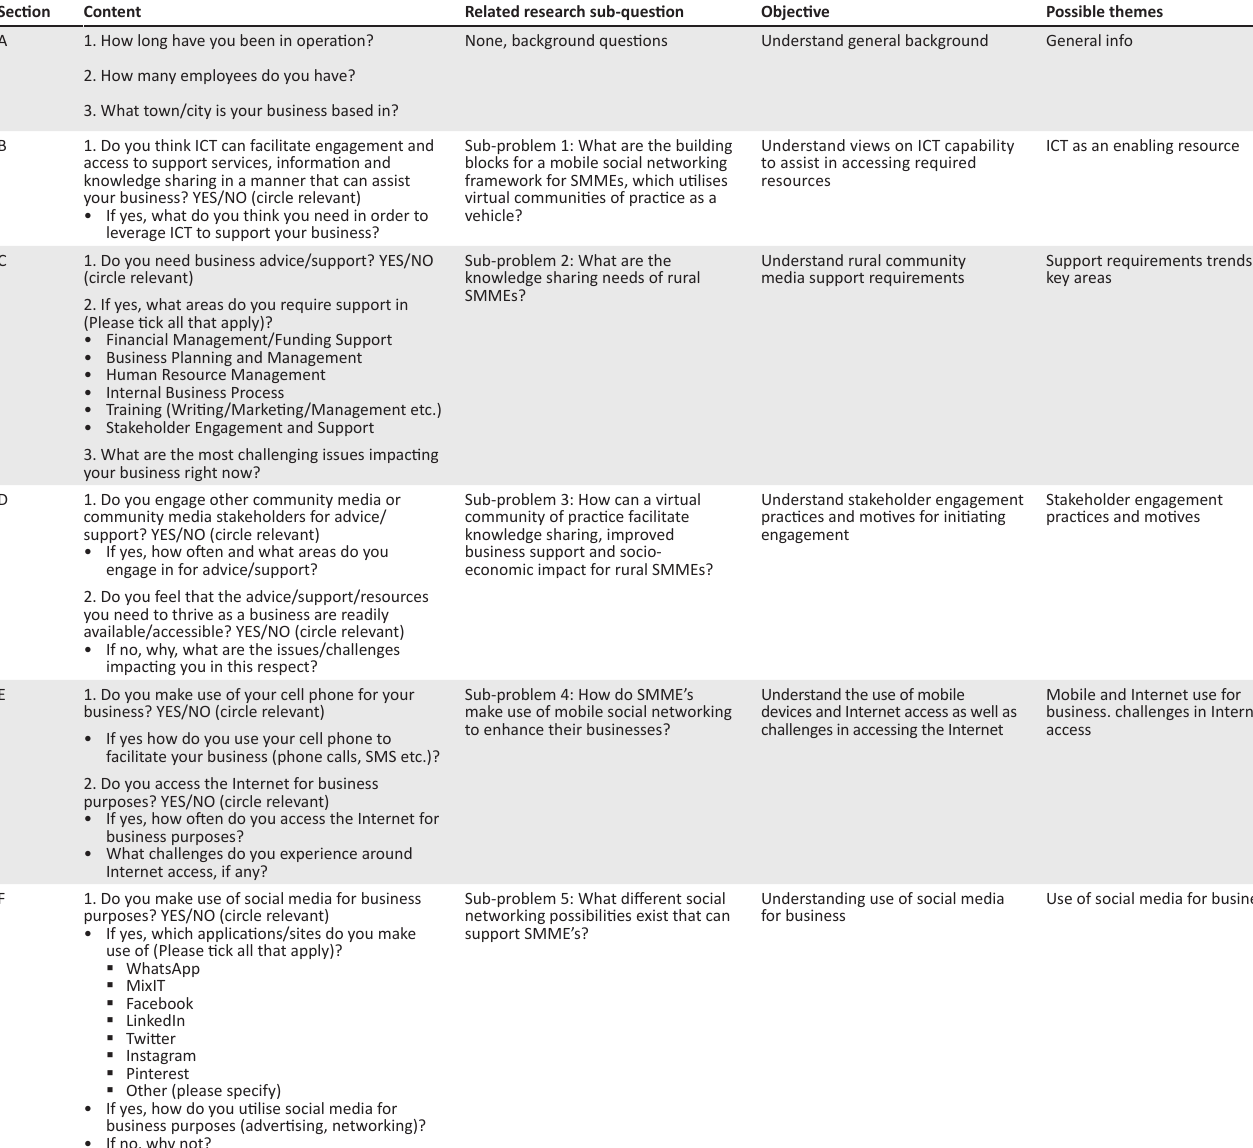
TABLE 1: Research questions and questionnaire linked to possible themes.